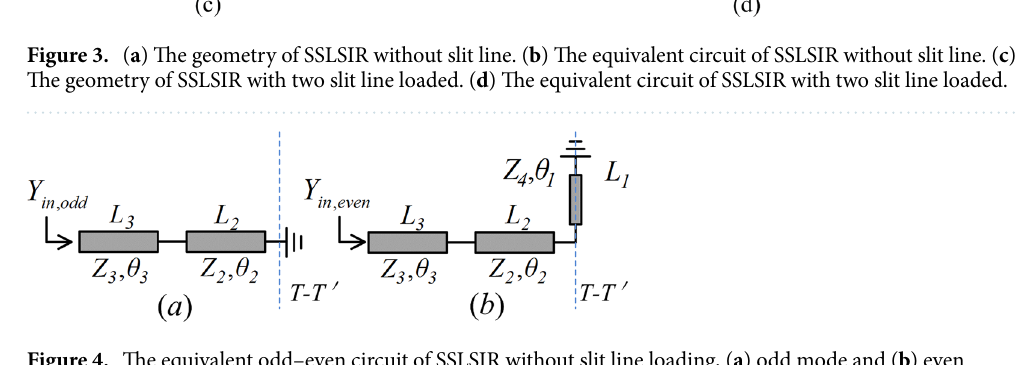
Figure 4. The equivalent odd–even circuit of SSLSIR without slit line loading, ( a ) odd mode and ( b ) even